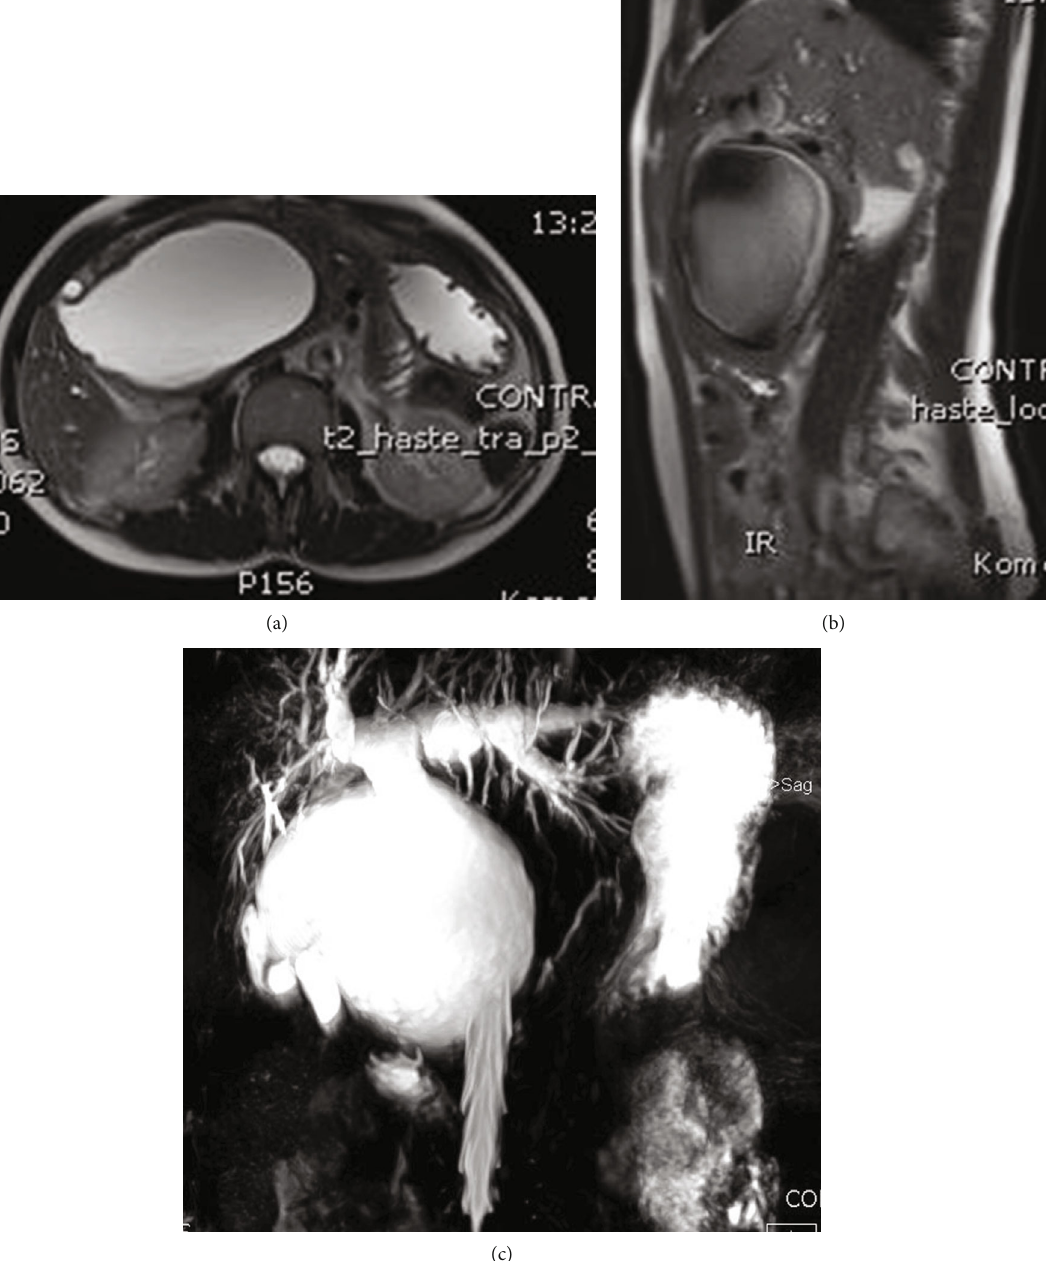
Figure 1: Magnetic resonance cholangiopancreatography fi nding. MRCP displays a large choledochal cyst in axial (a) and coronal (b) view of the abdomen. Cyst of the common bile duct and common hepatic duct, with partial dilatation of left and right hepatic ducts, without existing gallbladder